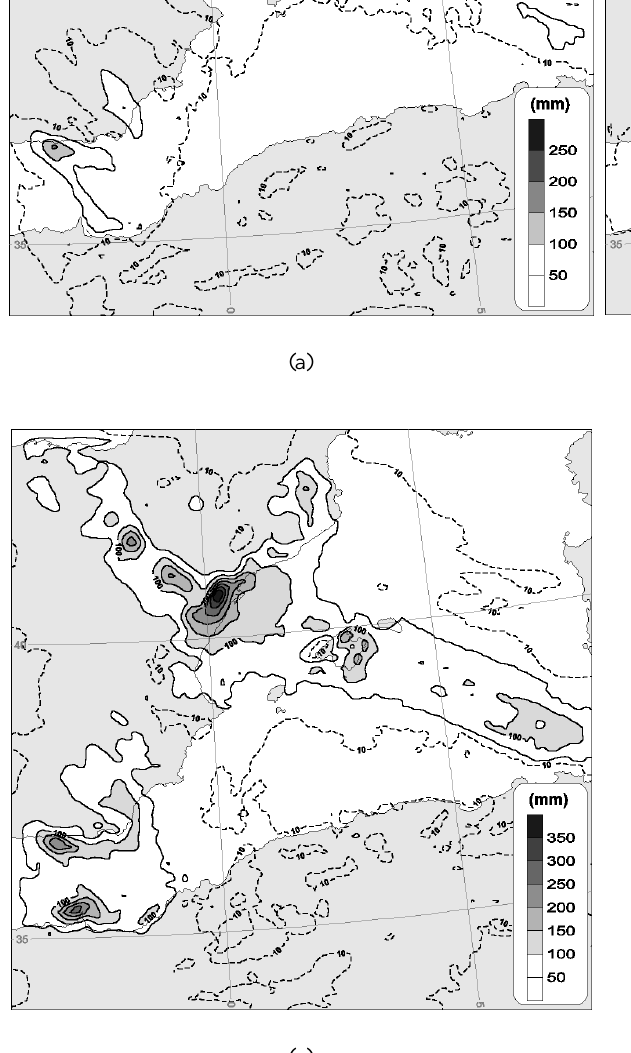
Fig. 7. Model simulated accumulated precipitation (mm, domain 3) from 06:00UTC to 06:00UTC the next day on: (a) 22 and (b) 23 October 2000. (c) Shows the total accumulated precipita- tion (mm) in the control simulation for 22 and 23 October (sum of a and b). Note the change of precipitation scale between the first two panels and